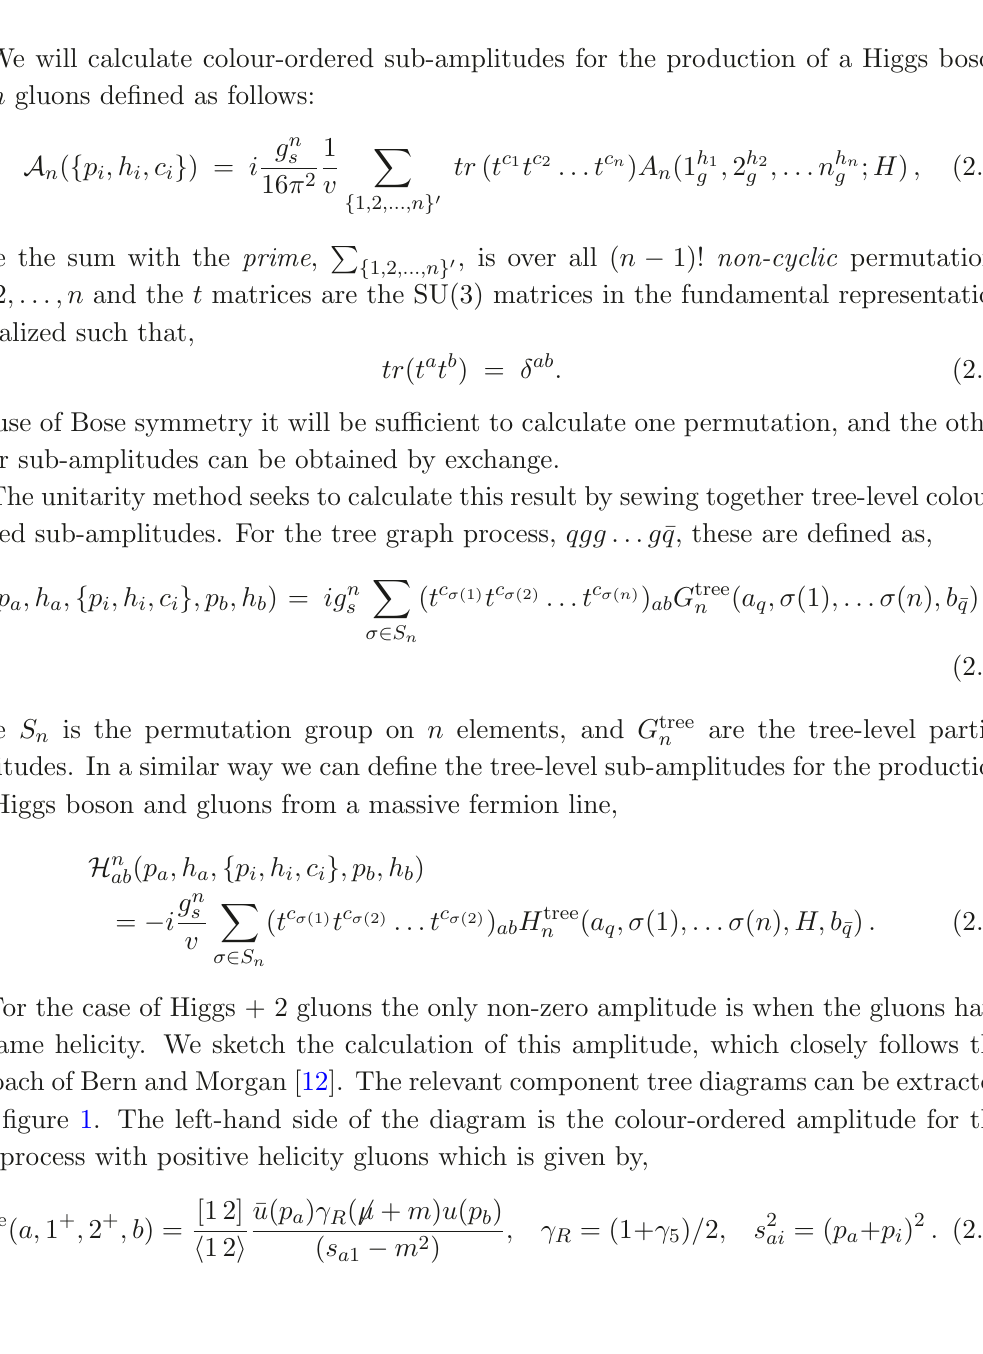
Figure 1 . Unitarity approach to calculating the Higgs + 2 gluon